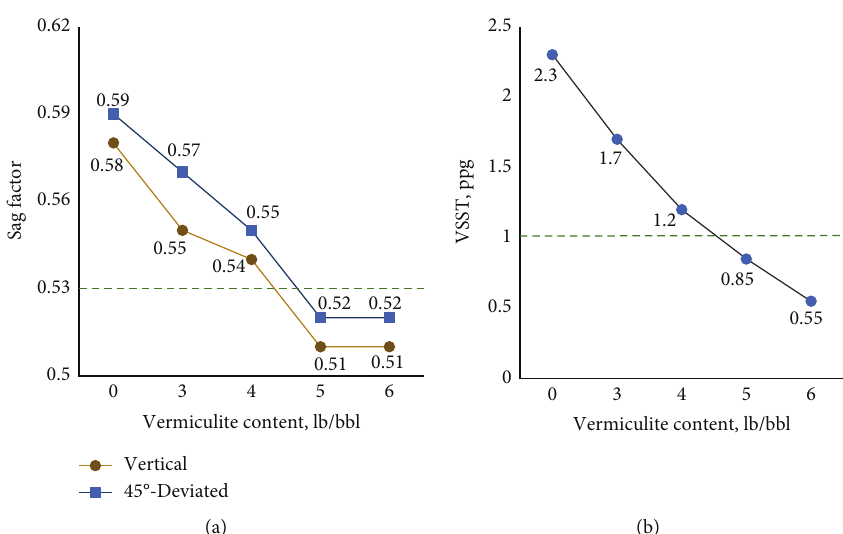
Figure 4: E ff ect of adding vermiculite on sag factor under (a) static conditions at 300 psi and 250 ° F and (b) dynamic conditions at 120 ° F.